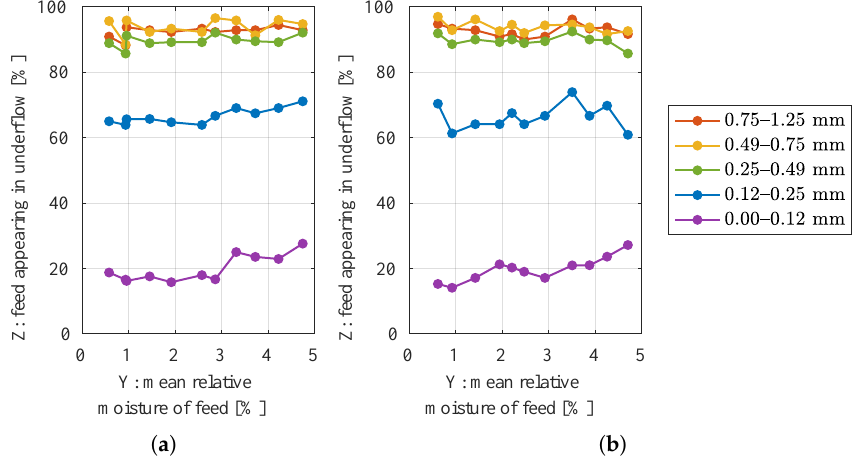
Figure 6. Degrees of separation from each experiment grouped by granularity class, in relation to input material moisture. The material was supplied to the separator at: ( a ) 50%, ( b ) 100% of the nominal throughput of the screw feeder. Table 1. Assessment of correlation between moisture level and degree of separation for each gran- ularity class, separately for experiments with different material throughput of the screw